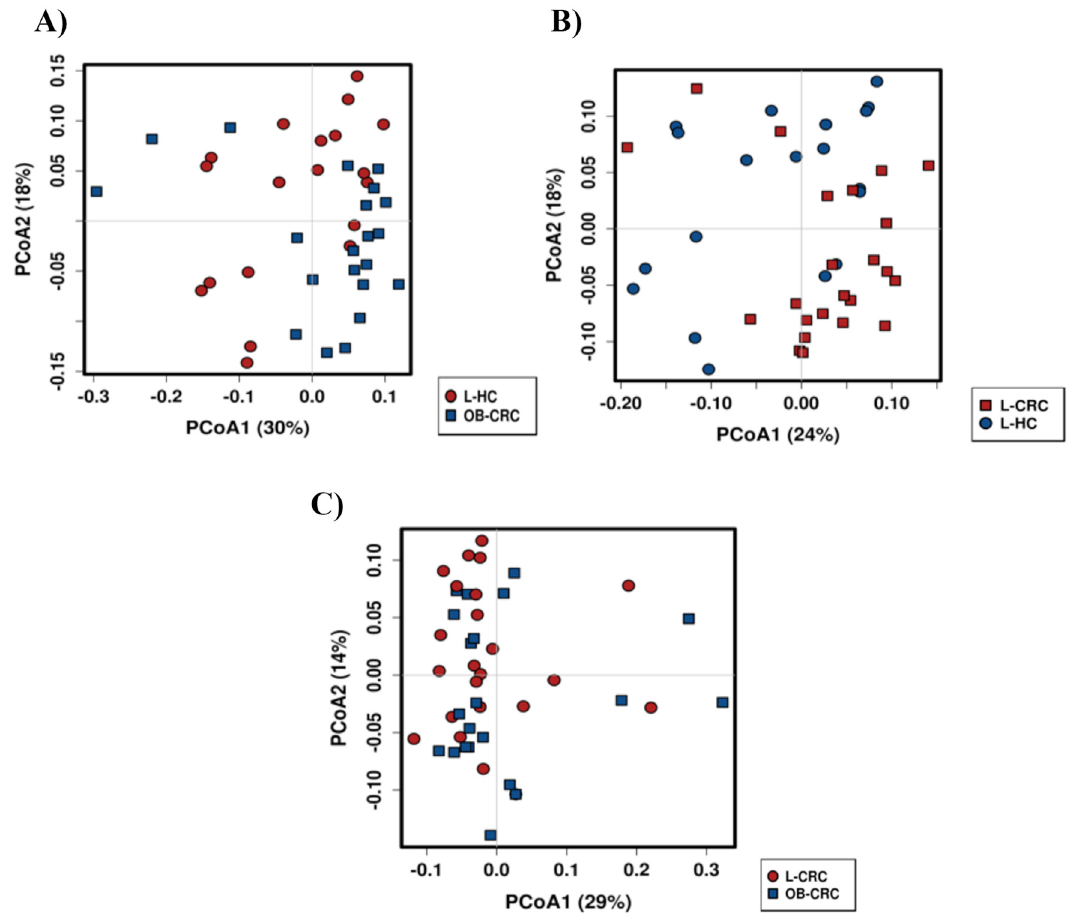
Figure 2. Clustering of fecal bacterial communities according to the different study groups by PCoA using Bray–Curtis dissimilarity matrix. Each point corresponds to a community coded according to the study groups. The percentage of variation explained by the plotted principal coordinates is indicated on the axes. ( A ) L-HC vs. OB-CRC, ( B ) L-CRC vs. L-HC, and ( C ) L-CRC vs. OB-CRC.